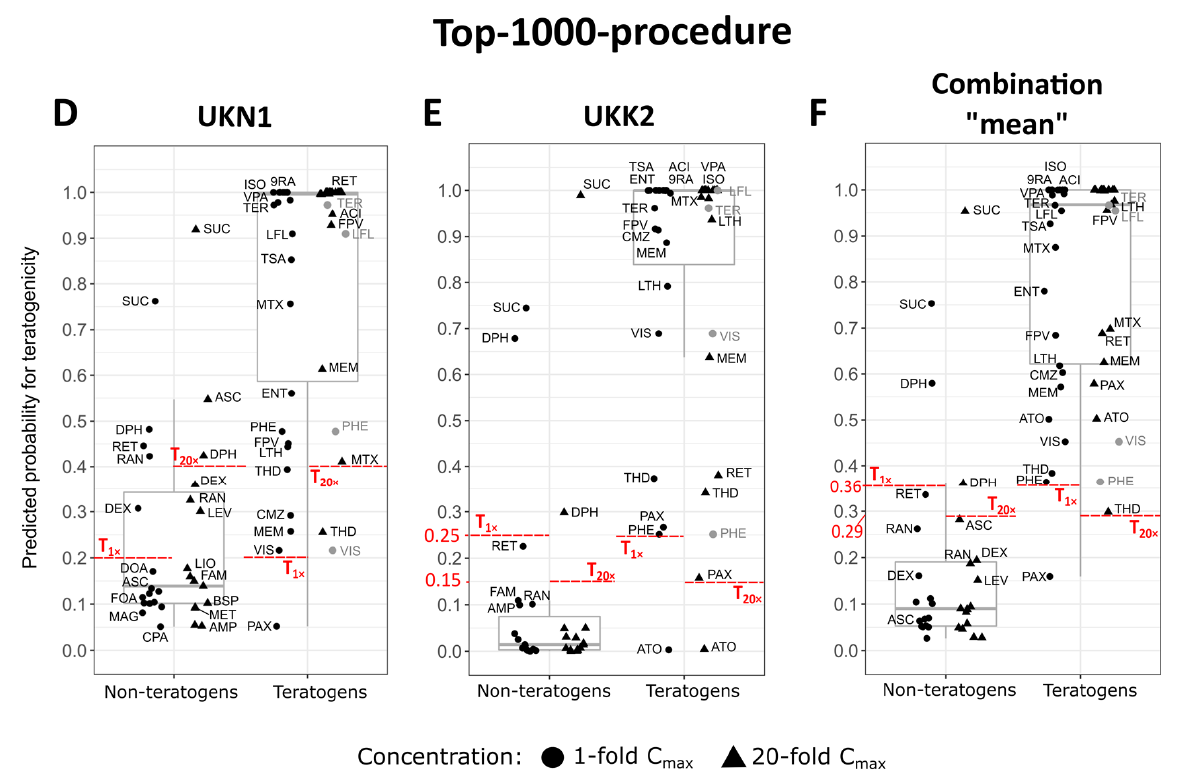
Figure 4. Classification of the teratogenic and non-teratogenic compounds by the SPS-procedure, a method based on the number of significantly deregulated probe sets (SPS), and the top-1000- procedure, a penalized logistic regression-based technique using the 1000 probe sets with the highest variance. ( A – C ) SPS-procedure. The number of SPS for each test condition is given on the y -axis and the x -axis marks non-teratogens and teratogens (compound abbreviations are explained in Table 1). 1-fold-C max conditions are indicated with black dots, 20-fold C max conditions with black triangles. Grey dots represent the numbers of SPS at 1-fold C max of LFL, PHE, TER, and VIS, which were com- pared to 20-fold C max thresholds. For the UKK2 test, SPS numbers were adapted from Cherianidou et al. 2022, but retinol at 20-fold C max was considered as a teratogen. SPS numbers above or below the thresholds T 1 × and T 20 × (red dashed lines) for 1-fold and 20-fold C max conditions, respectively, were considered to be test-positive or test-negative. Cytotoxic conditions were considered to be test-positive and were assigned with a high number of SPS (UKN1: 4318; UKK2: 4257). Thresholds UKN1 ( A ): 1-fold-C max : 1 SPS; 20-fold-C max : 1000 SPS; UKK2 ( B ): 1-fold-C max : 270 SPS; 20-fold-C max : 360 SPS; combination ‘mean’ ( C ): 1-fold-C max : 130 SPS; 20-fold-C max : 500 SPS. ( D – F ) Top-1000- procedure. The predicted probability for teratogenicity is given on the y -axis, and the x -axis marks non-teratogens and teratogens. Cytotoxic conditions were considered to be 100% test-positive (predicted probability of 1.0). Thresholds UKN1 ( D ): 1-fold-C max : 0.2; 20-fold-C max : 0.4; UKK2 ( E ): 1-fold-C max : 0.25; 20-fold-C max : 0.15; combination ‘mean’ ( F ): 1-fold-C max : 0.36; 20-fold- C max :